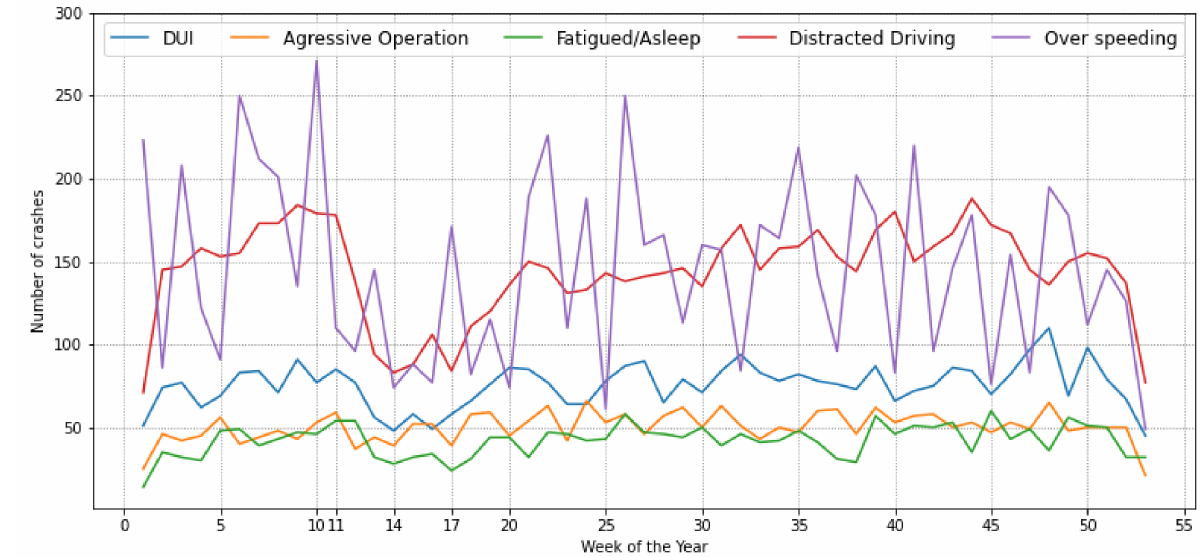
Figure 3. Distribution of total crashes by some primary contributing factors.